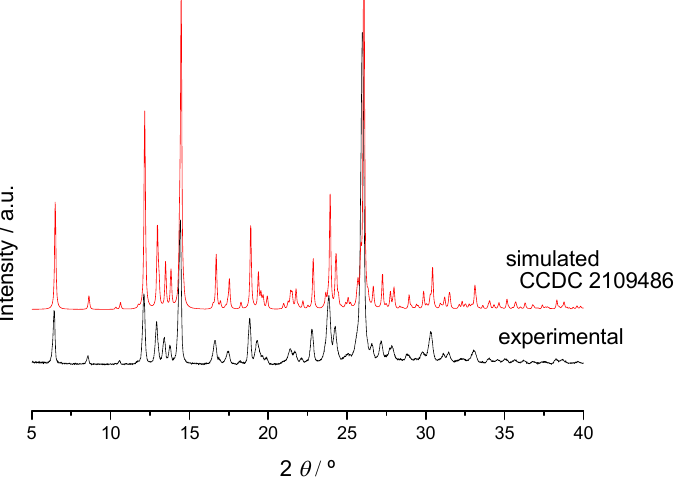
Figure 12. Experimental X-ray powder diffractogram of (1:2) DAP + THEO 1:2 co-crystal and simulated for the (1:2) + 17 % H 2 O solved structure, CCDC 2109486.